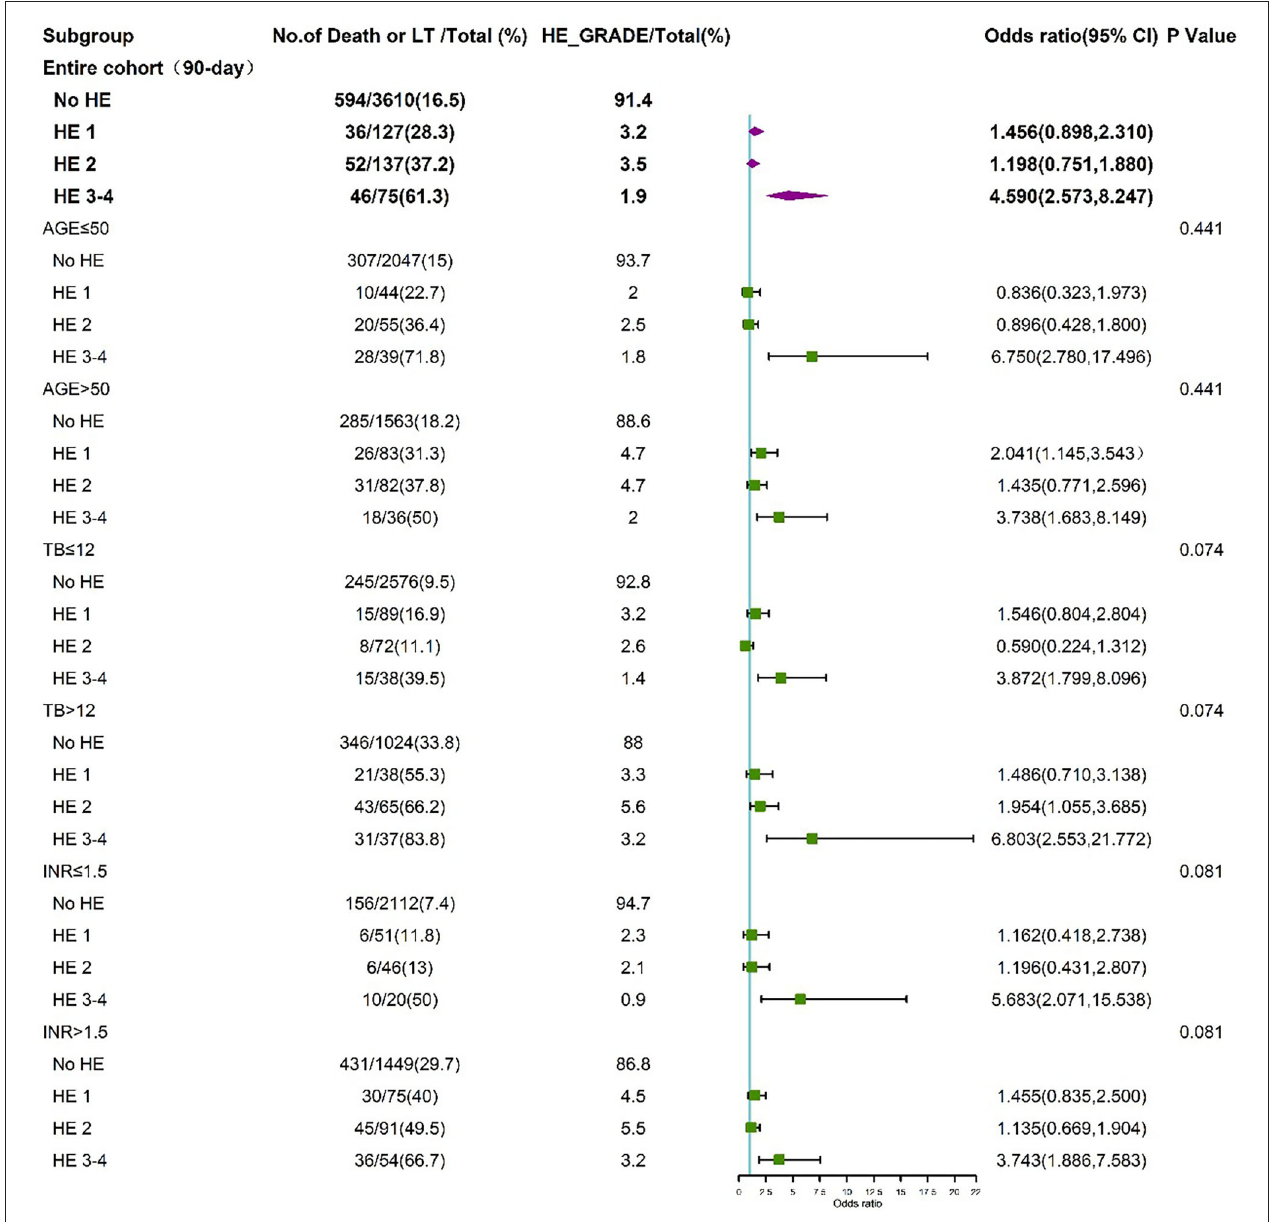
FIGURE 6 | Stratified analyses of 90-day adverse outcome by HE grades. HE, hepatic encephalopathy; TB, total bilirubin; INR, international normalized ratio; CI, confidence